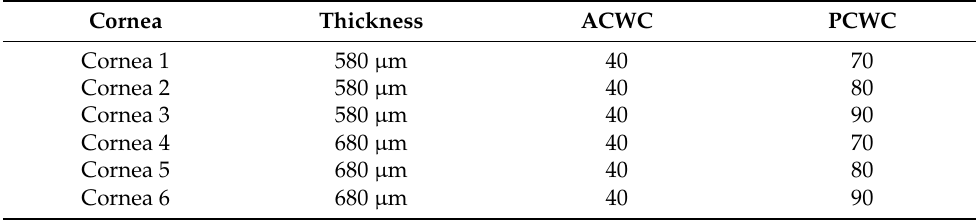
Table 1. Different cornea